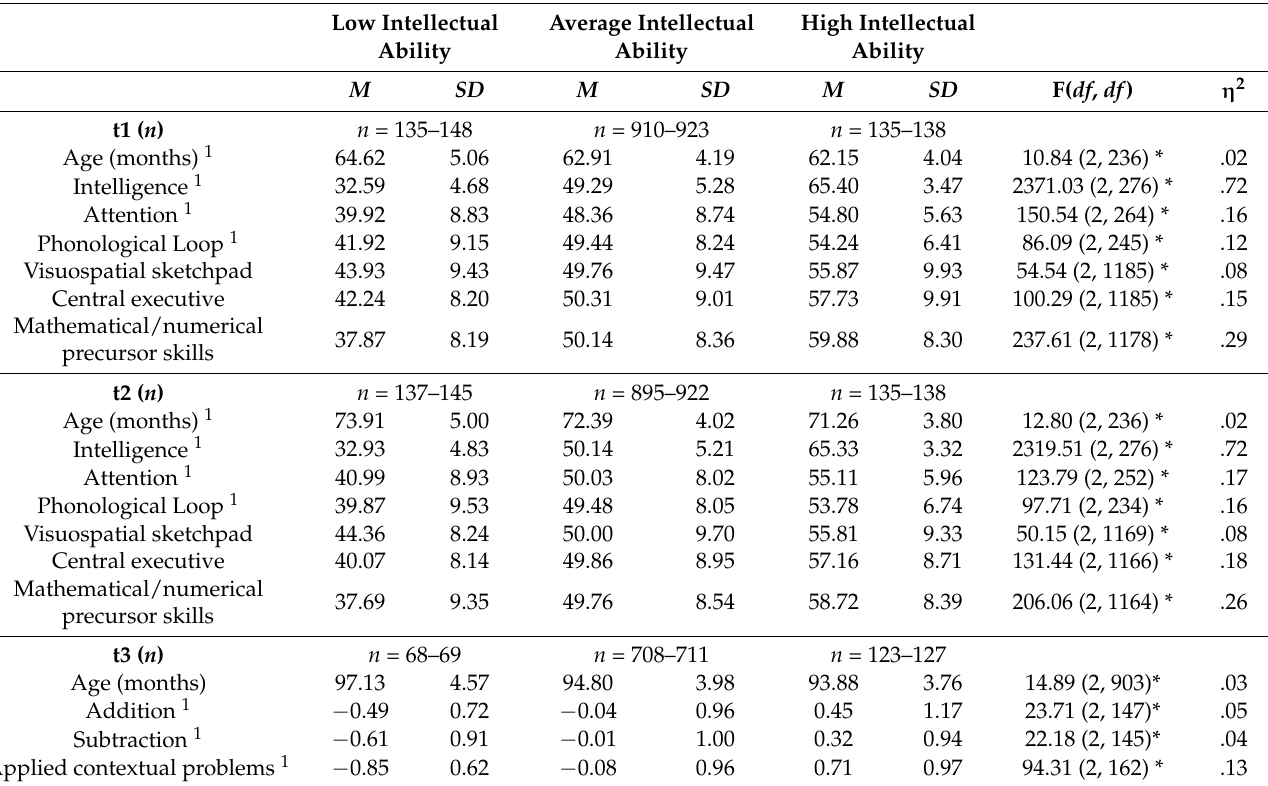
Table 6. Mean and standard deviation of tested variables of the three intellectual ability groups, as well as results of one-way ANOVA and effect size ( η 2